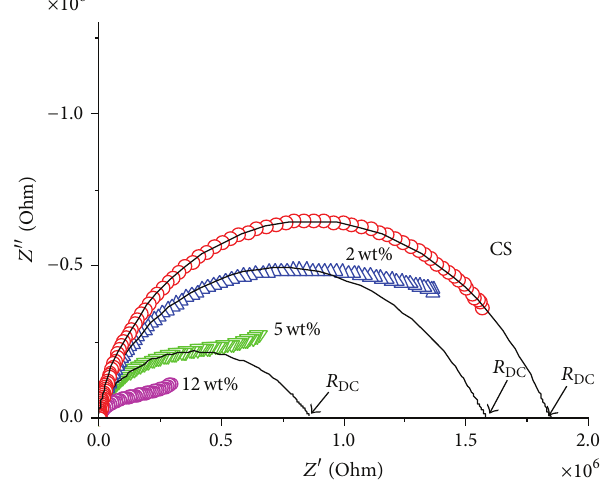
Figure 5: DC conductivity of CS-clay films as a function of the clay wt%. Insert shows the log-log dependence of the conductivity of the CS composites on ( 𝑝 − 𝑝 𝑐